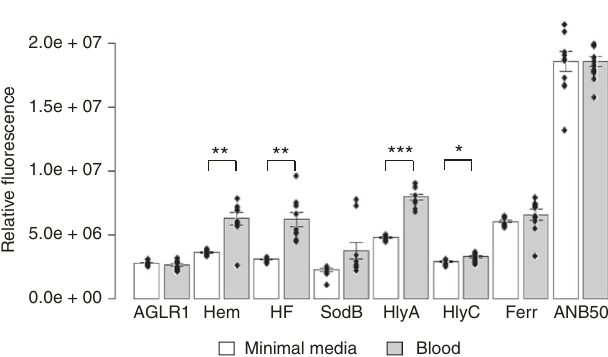
Fig. 1 Putative BMI promoters signi fi cantly increase fl uorescence of four Asaia conditional strains when exposed to blood. There was a signi fi cant difference in mean fl uorescence for four BMI isolates in minimal media compared to media supplemented with blood (Welch ’ s t -test, n = 10 for each strain and condition). No signi fi cant difference between the different media was seen for both the positive (ANB50) and negative (AGLR1) controls, as well as the SodB and Ferr strains. Fluorescence readings were taken during log phase and normalized to the OD 600 of each culture. Height of bars are the mean value for that treatment. Error bars represent standard error of the mean (s.e.m.) ( n = 10). Individual data points are superimposed on the bar charts. Statistical signi fi cance was determined using Welch ’ s two-tailed t -test where signi fi cance is represented by * P < 0.05, ** P < 0.01, and *** P < 0.001. Only signi fi cant differences are labeled